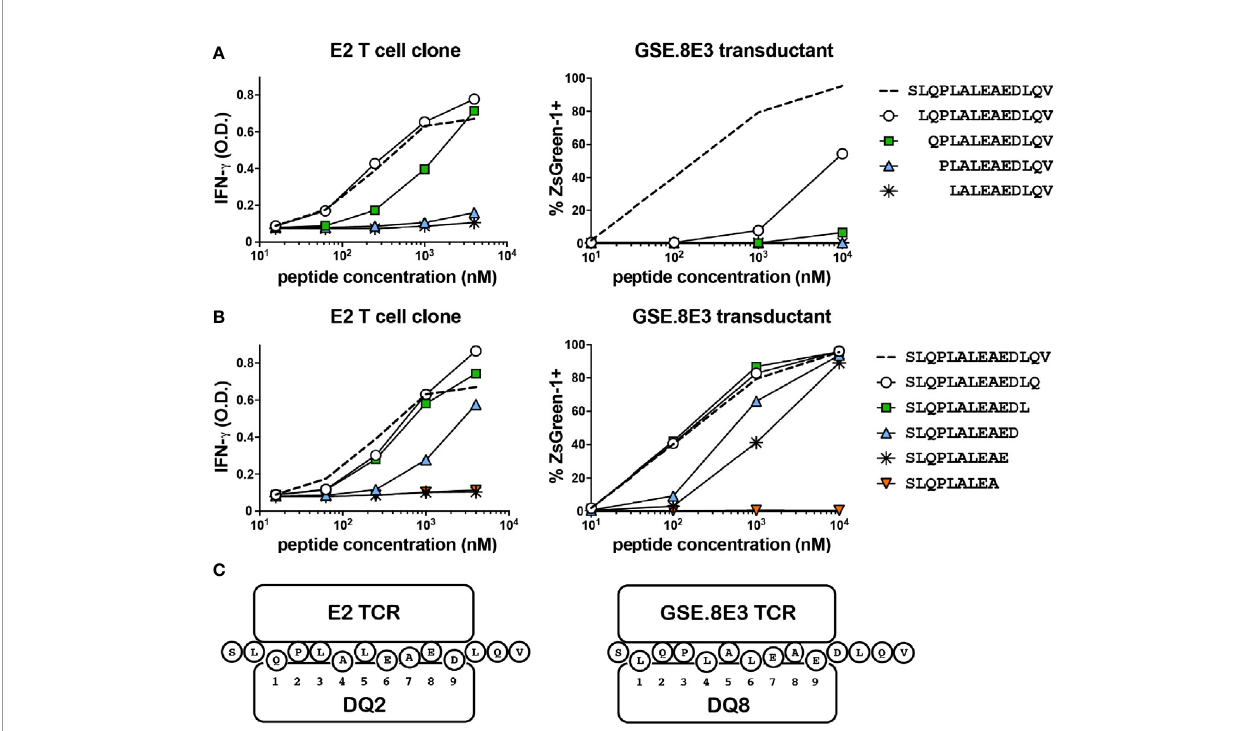
FIGURE 4 | The E2 CD4 T cell clone and the GSE.8E3 TCR transductant recognize different minimal epitopes. N-terminally (A) and C-terminally (B) truncated HIP11 peptides were tested with E2 and GSE.8E3 for antigenicity. Results are representative of three independent experiments. (C) Proposed binding registers for HIP11 in the context of DQ2 or DQ8 when recognized by E2 or GSE.8E3, respectively.